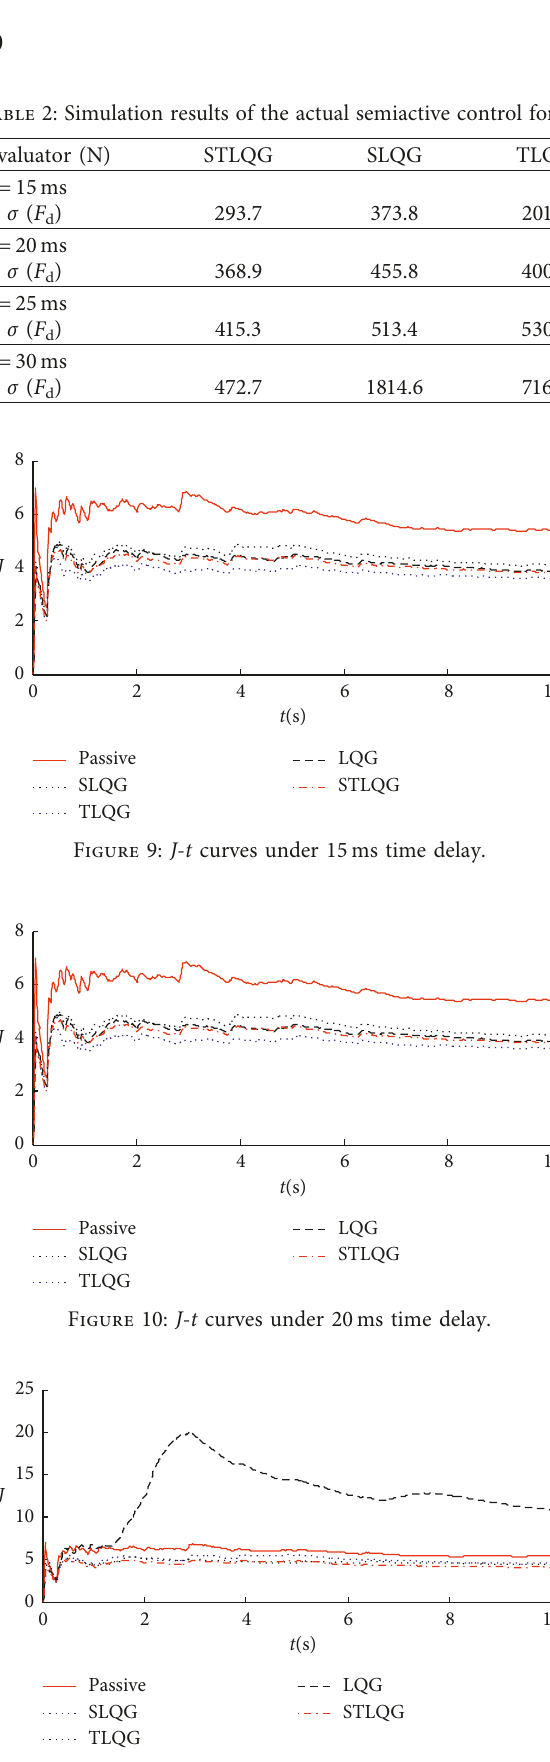
Figure 15: PSD ( a 2 )-frequency curves under 25 ms time delay.